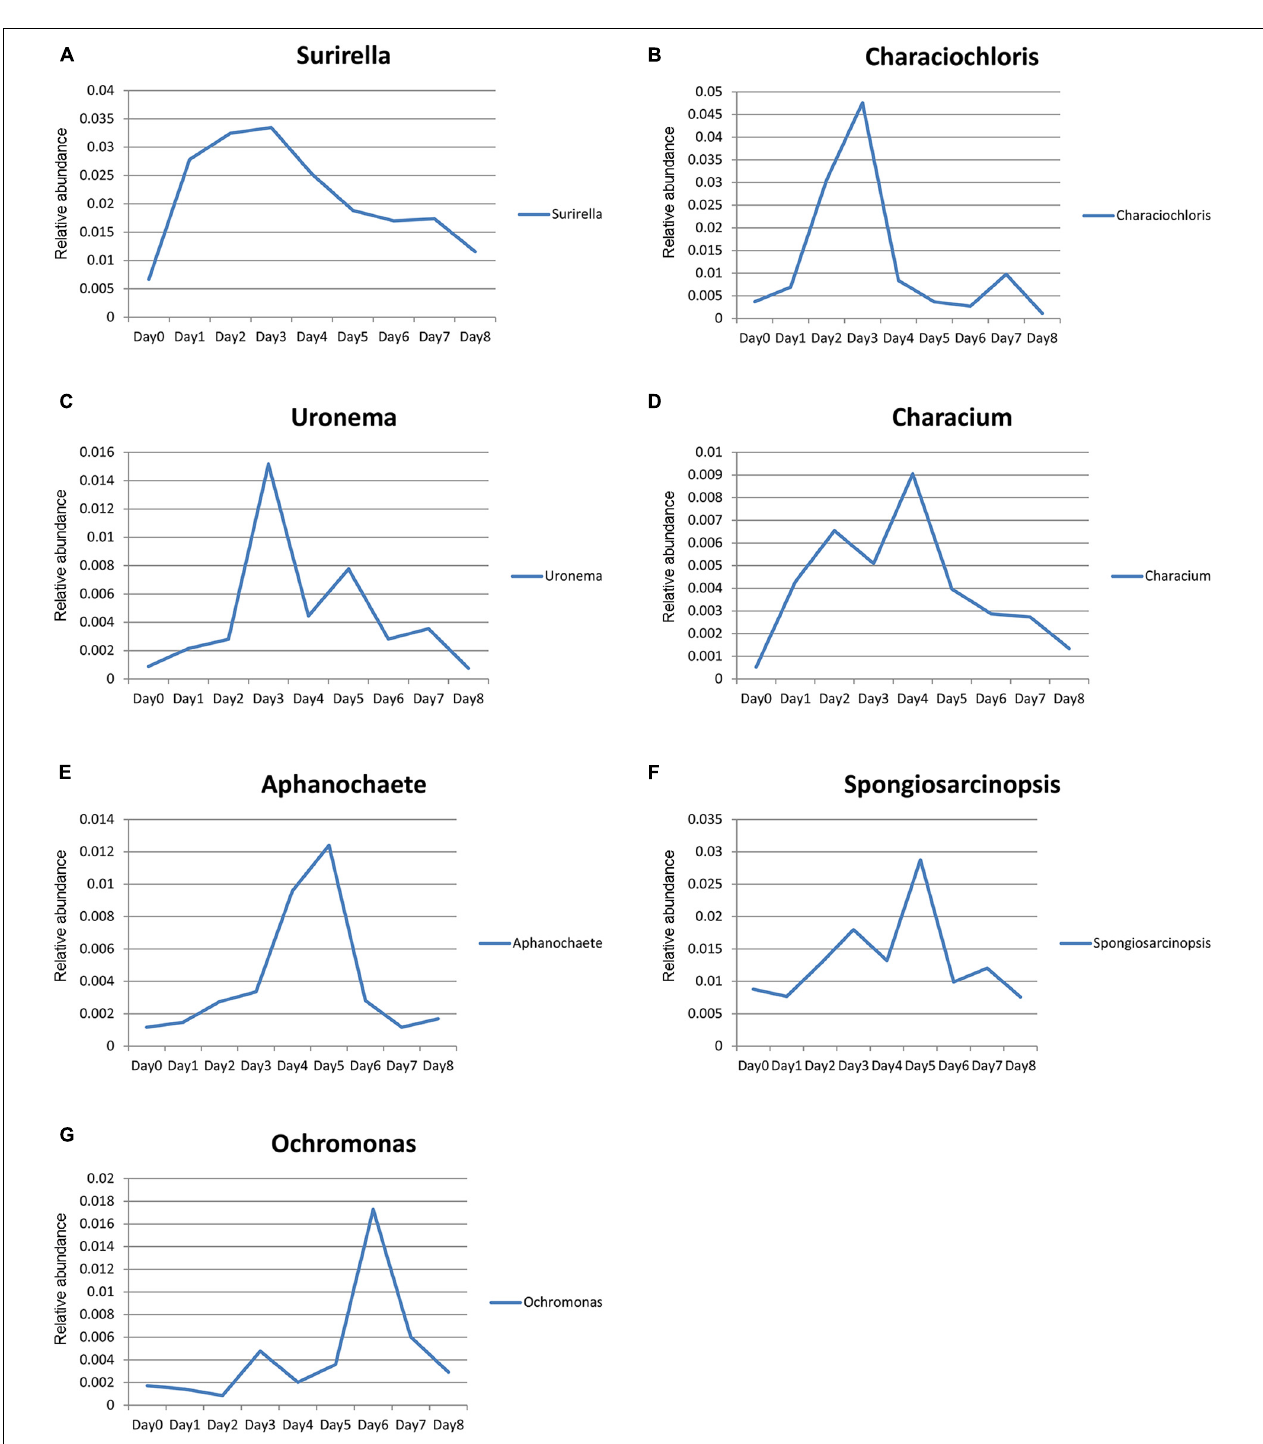
FIGURE 7 | Relative abundance changes of seven species of algae with time. (A) Surirella ; (B) Characiochloris ; (C) Uronema ; (D) Characium ; (E) Aphanochaete ; (F) Spongiosarcinopsis ; (G) Ochromonas .